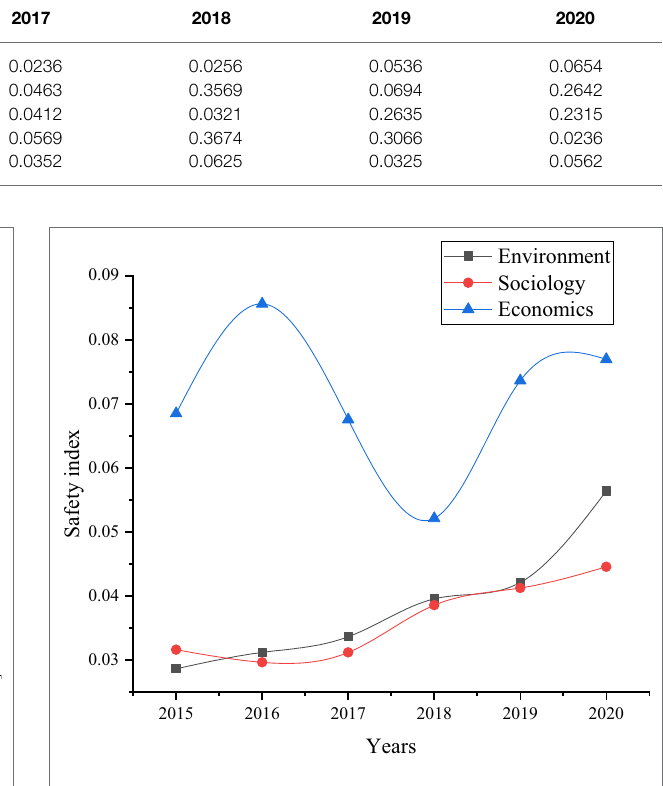
FIGURE 9 | Changes in the food security index from 2015 to 2020.